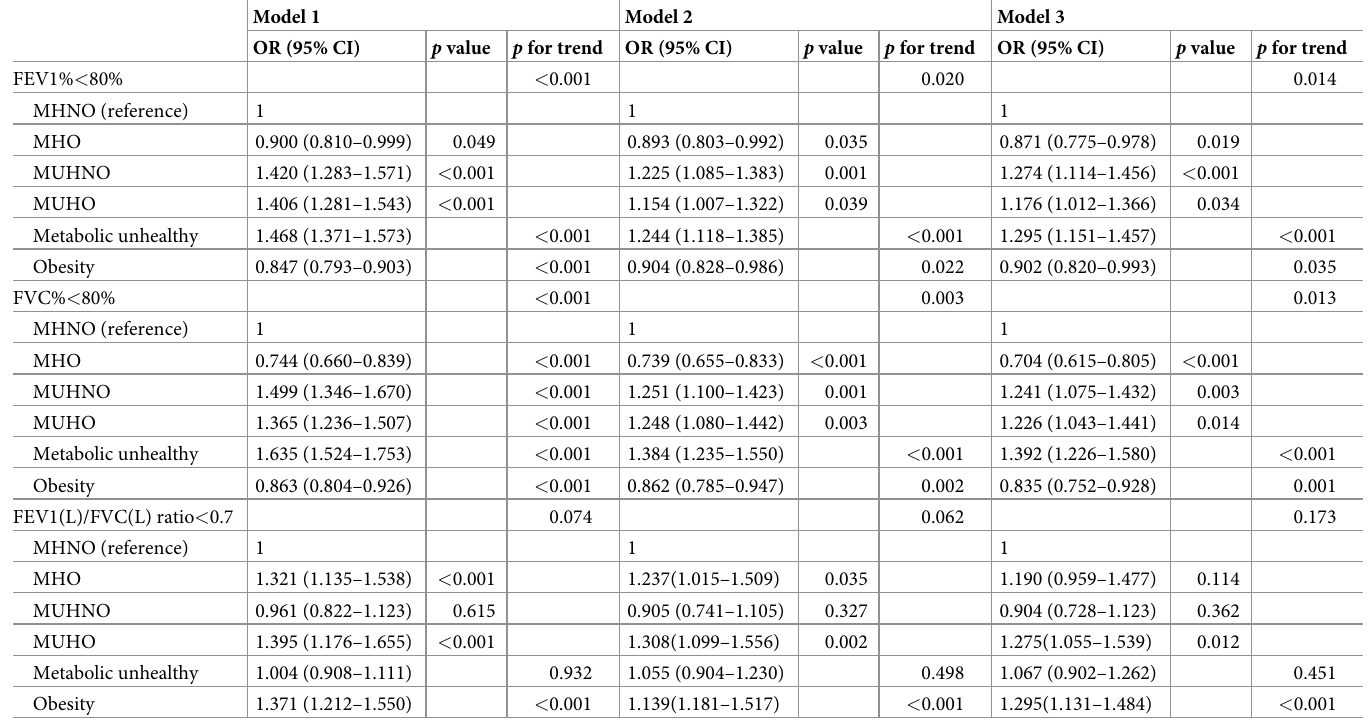
Table 4. Multiple logistic regression analysis of impaired spirometric parameters according to metabolic health and obesity